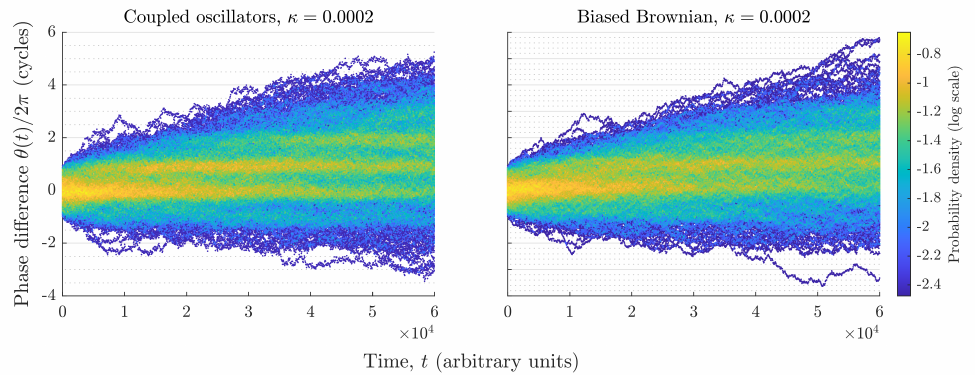
Figure 9. Probability density function of θ ( t ) over time for ( left ) deterministic and ( right ) stochastic ( Θ t ) models for κ = 0.0002 and the same initial conditions. Intermittent phase locking is present even for so small a coupling strength.